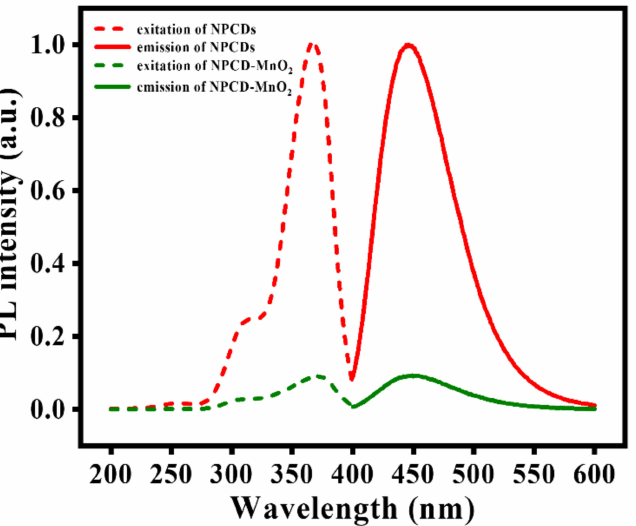
Figure 2. Emission and excitation fluorescent spectra of NPCDs and the NPCD-MnO 2 nanocoral